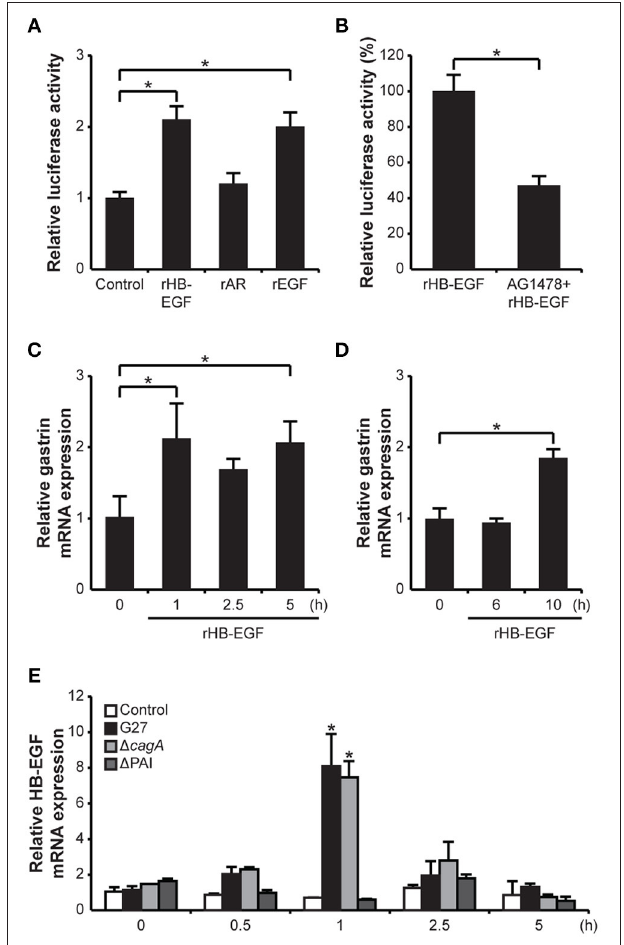
FIGURE 4 | Effect of HB-EGF on transcription and promoter activity of gastrin, and effect of H. pylori on transcription of HB-EGF. (A) G240-Luc cells were stimulated with 10nM of each recombinant HB-EGF (rHB-EGF), AR (rAR), or EGF (rEGF) for 5h and gastrin promoter activity was measured by luciferase assay. (B) G240-Luc cells were pretreated with EGF receptor kinase inhibitor AG1478 (1 µ M) for 30min and subsequently stimulated with rHB-EGF. Gastrin promoter activity was measured by luciferase assay. (C) AGS cells or (D) GES-1 cells were stimulated with rHB-EGF for the indicated durations. Transcription levels of gastrin were relatively quantified by qRT-PCR. (E) After H. pylori infection for the indicated durations, HB-EGF mRNA expression was measured by qRT-PCR. Each result is presented as a fold change relative to the control ± SD . * P < 0.05.